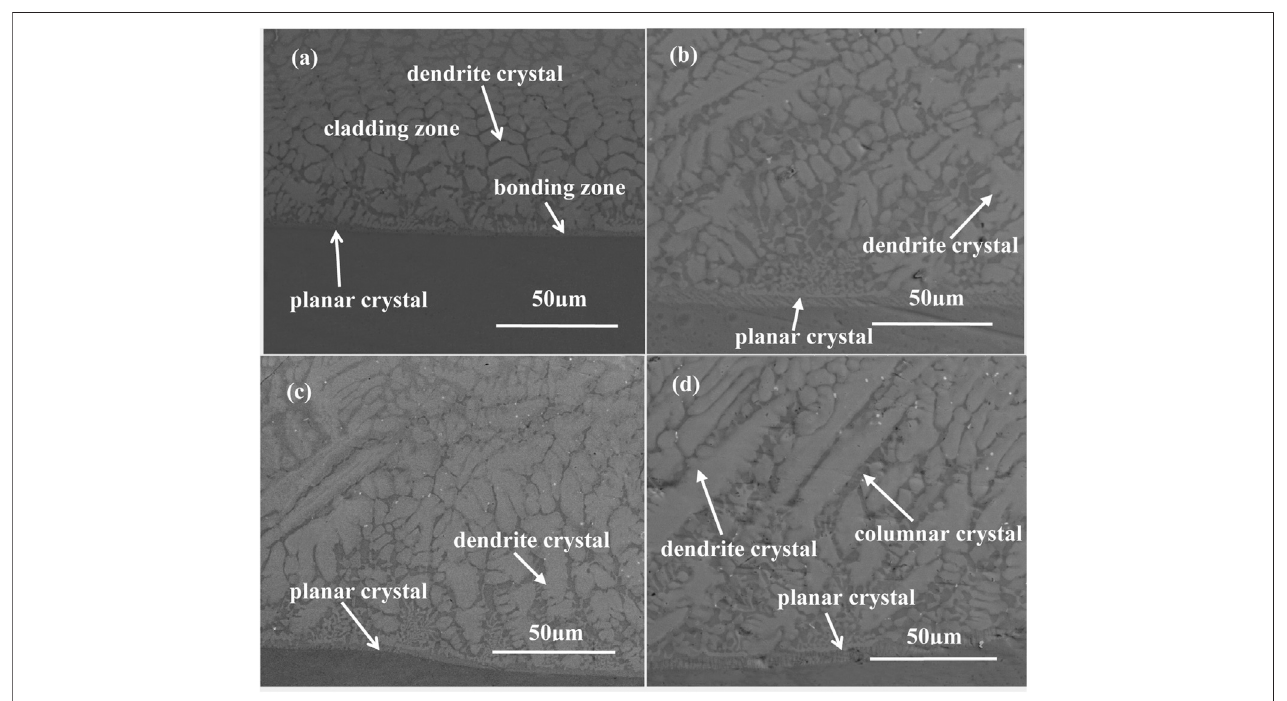
FIGURE 4 | Cross-sectional morphologies of the as-deposited coatings near the interface: (A) 0 wt% Sm 2 O 3 ; (B) 1 wt% Sm 2 O 3 ; (C) 3 wt% Sm 2 O 3 ; (D) 5 wt% Sm 2 O 3